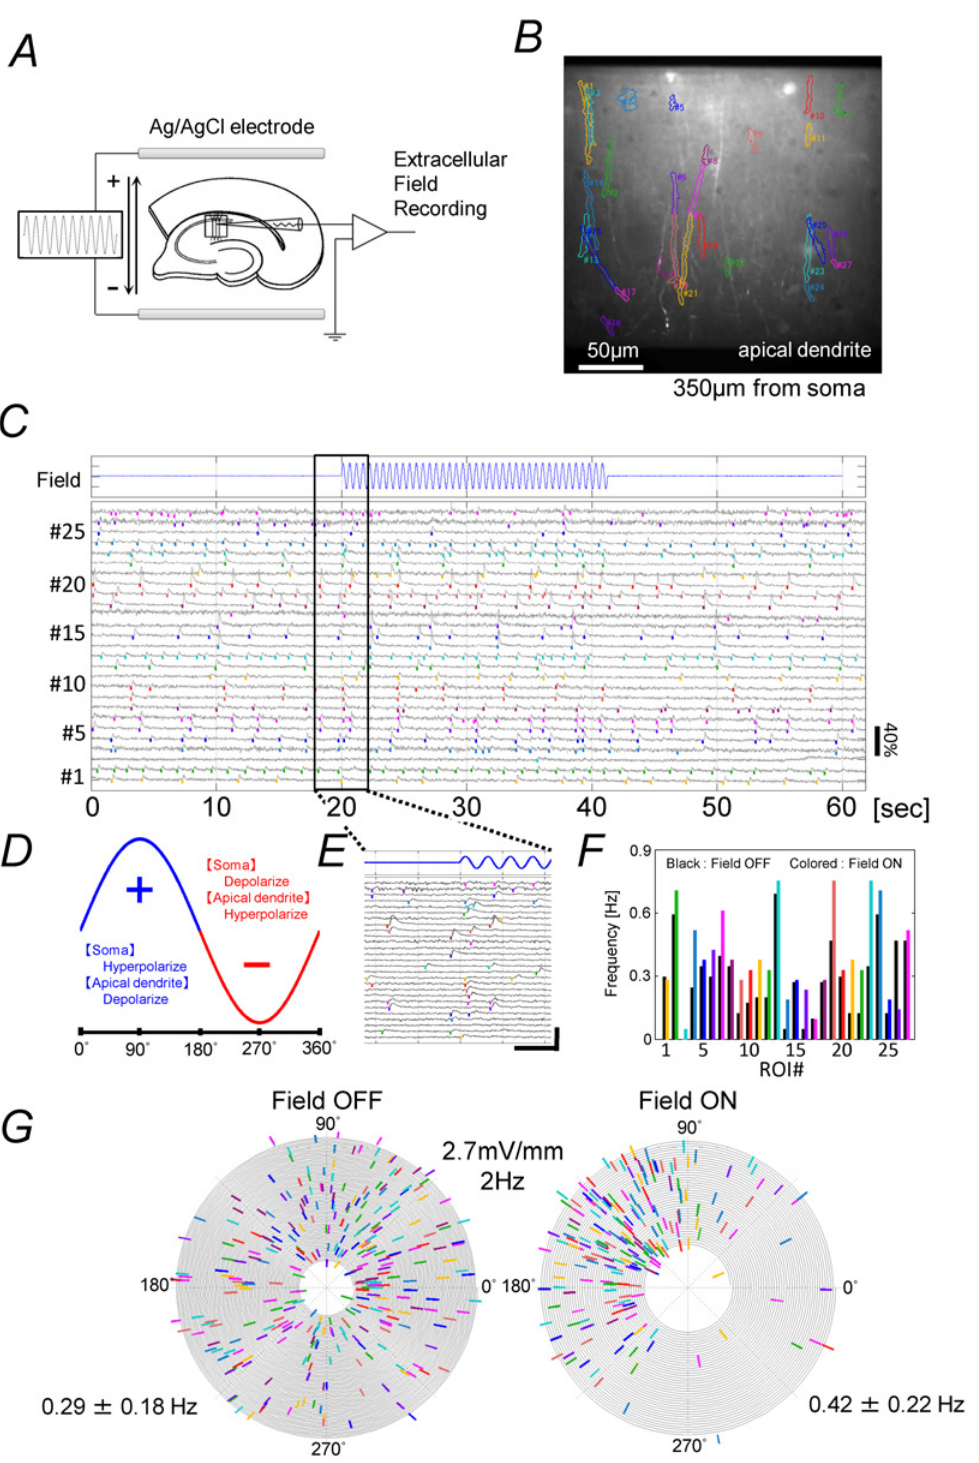
Fig 6. Analysis of the impact of sinusoidal extracellular electric fields on fast-Ca-transients. ( A ) Arrangement of the electrodes for field stimulation. Electric current was applied between a pair of Ag/AgCl electrodes to generate electric field. The intensity of the field was monitored by measuring bath potential. ( B ) ROIs for the data shown in ( C ). The center of the image field was 350 μ m from the border between the str. pyramidale and str. radiatum. ( C ) Representative data showing fast-Ca-transients during sinusoidal field stimulation. After recording Ca signals for 20 sec in ACSF/4-AP containing 7.5 mM K + ion, field stimulation (2.7 mV/mm, 2 Hz (1.88 Hz), 20 cycles)was turned on for 20 sec, then off for further 20 sec while recording the signals. Scale bar ( Δ